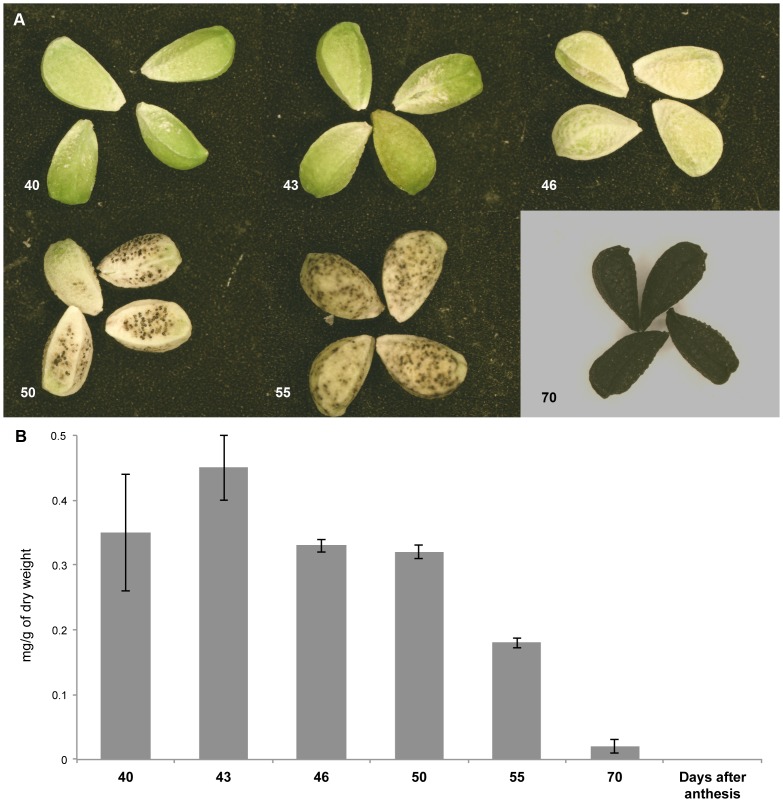
Phenotype (A) and chlorophyll content (B) of Nigella sativa developing seed from 40th to 70th DAA.